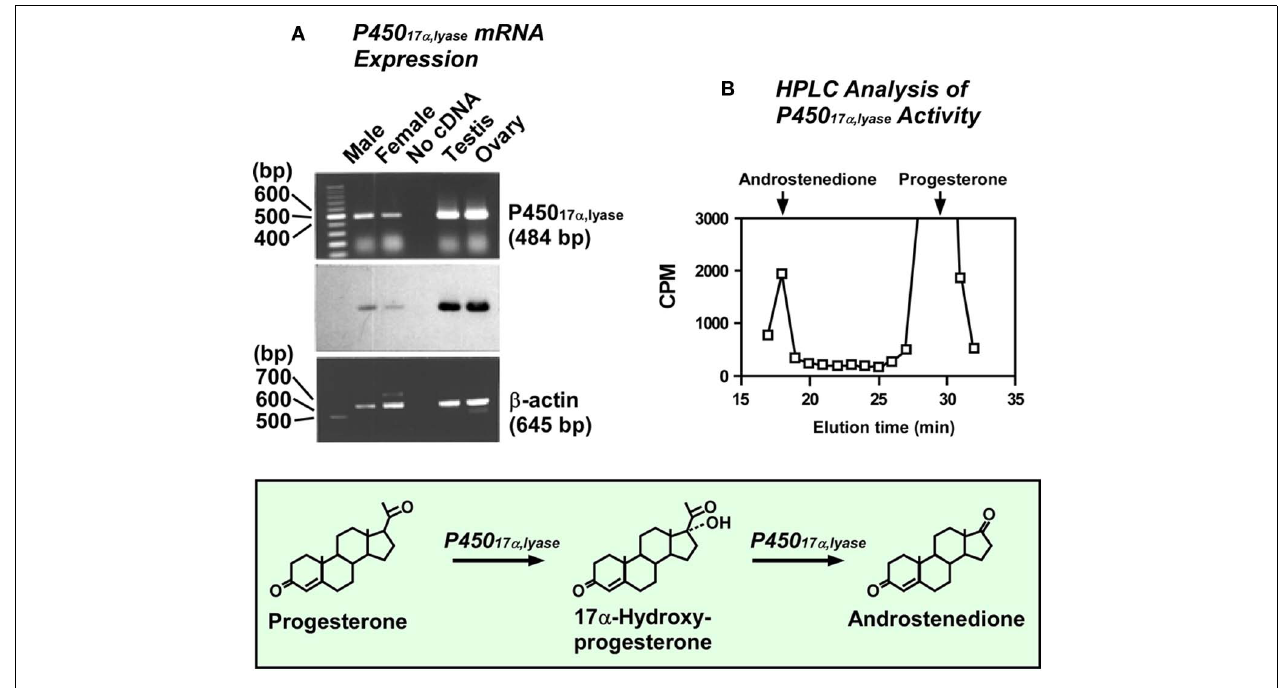
β -actin as the internal control. (B) HPLC analysis of neurosteroids extracted from quail diencephalic slices after 60min incubation with 3 H-progesterone using a reversed-phase column.The column was eluted with a 30-min linear gradient of 40–70% acetonitrile, followed by an isocratic elution of 70% acetonitrile.The ordinate indicates the radioactivity measured in each HPLC fraction.The arrows indicate the elution positions of progesterone and androstenedione. See Matsunaga et al. (2001, 2002) for